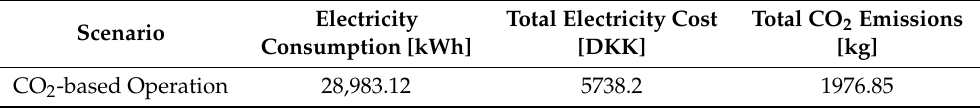
Table 9. Carbon-dioxide-based optimization results.